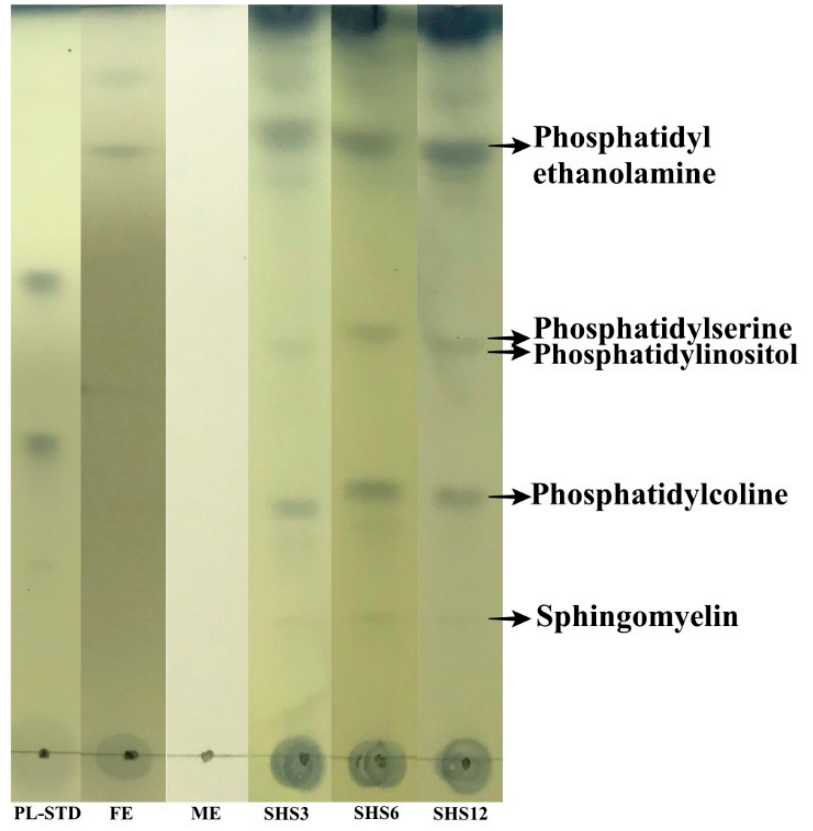
Figure 5. Representative thin-layer chromatography (TLC) plate of buttermilk showing the migration of the recovered phospholipids. PL-STD: the standard mixture of phospholipids; FE: Folch extraction; ME: Mojonnier extraction; SHS 3, 6, 12: switchable hydrophilicity solvent ratios 1/3, 1/6, 1/12, respectively.